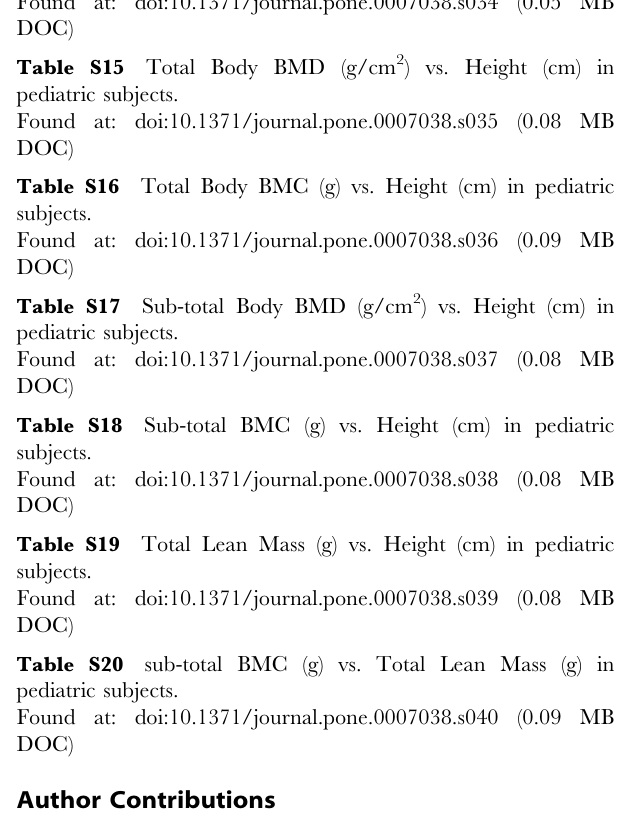
Table S12 Total Body BMC (g) vs. Age in Pediatric subjects.